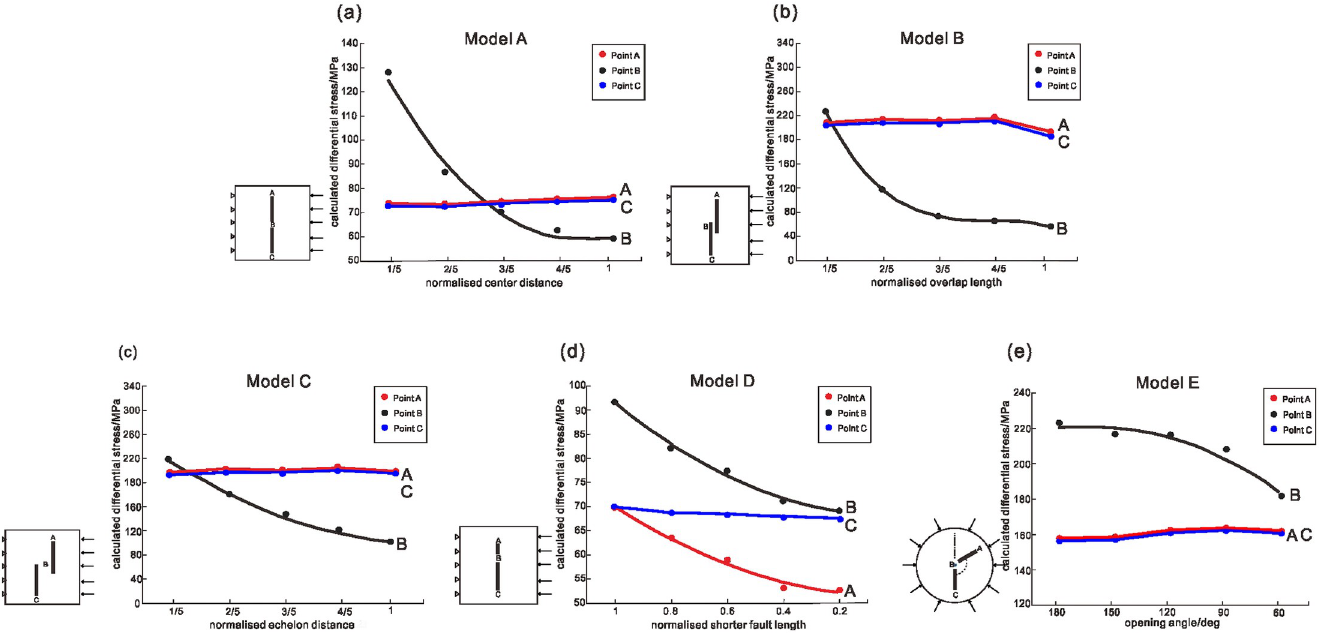
Fig 3. Calculated differential stresses as a function of normalized parameters for the four groups of models. In (a), the variations in the calculated differential stresses at points A, B and C are illustrated as a function of the normalized center distance. In (b), the variations in the calculated differential stresses at points A, B and C are illustrated as a function of the normalized overlap length. In (c), the variations in the calculated differential stresses at points A, B and C are illustrated as a function of normalized en echelon distance. In (d), the variations in the calculated differential stresses at points A, B and C are illustrated as a function of the normalized length of the shorter fault. In (e), the variations in the calculated differential stresses at points A, B and C are illustrated as a function of the opening